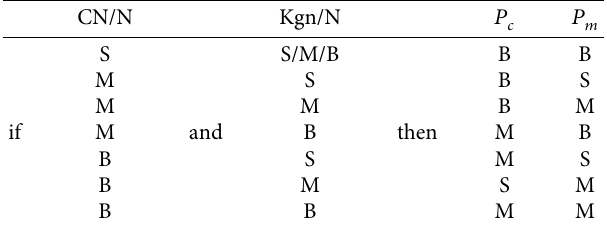
Table 3: Fuzzy inference